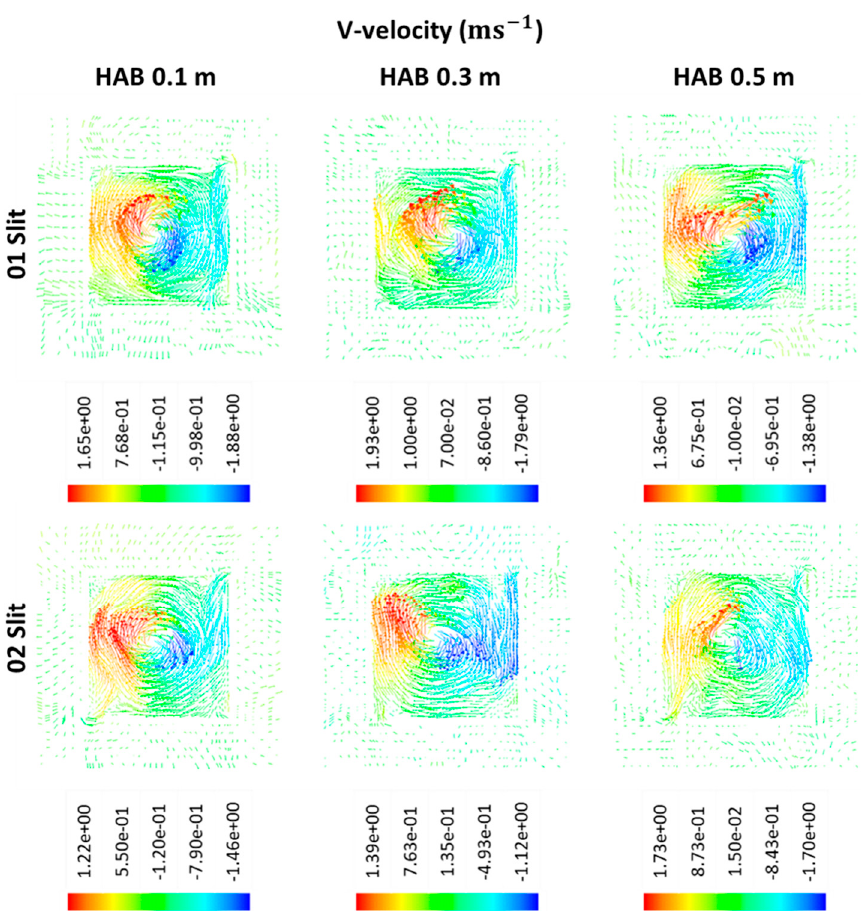
Figure 9. Plot of the vector field of V-velocity of the two cases, at all monitoring HABs.